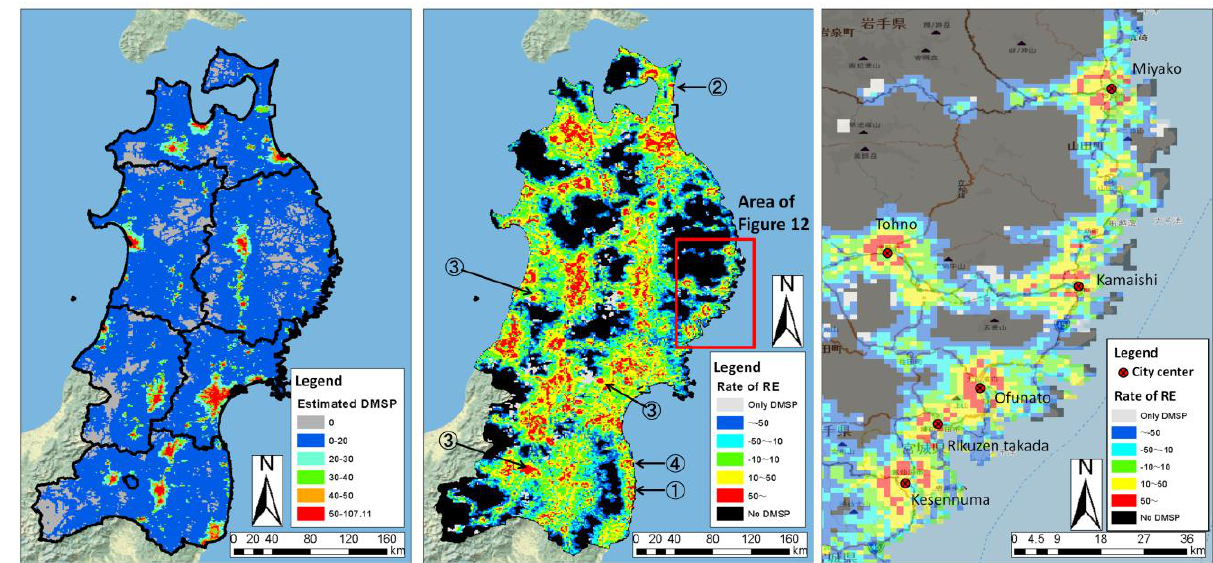
Figure 9. Estimated light intensity Figure 11. Rate of residual error Figure 12. Large residual errors